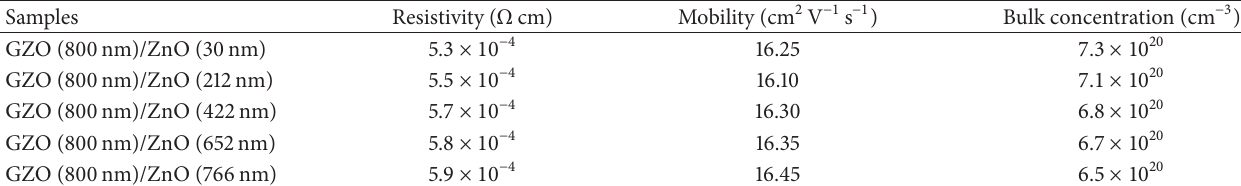
Table 2: Summary of the electrical properties of GZO films prepared at 400 ∘ C on various ZnO buffer layer thickness. Samples